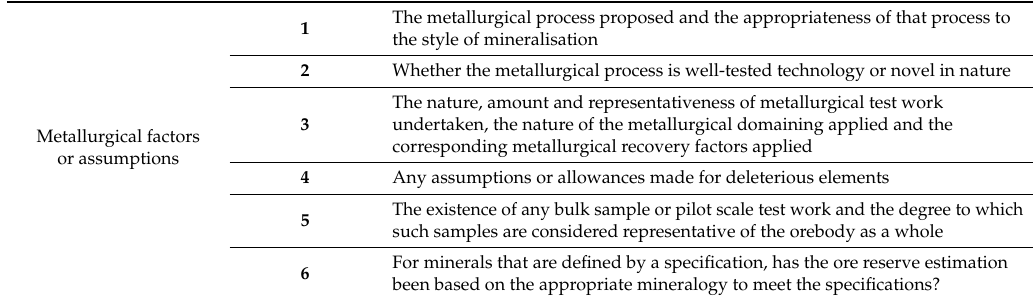
Table 26. Extract from The 2012 JORC Code Table 1 (Section 4) pertaining to metallurgical testwork